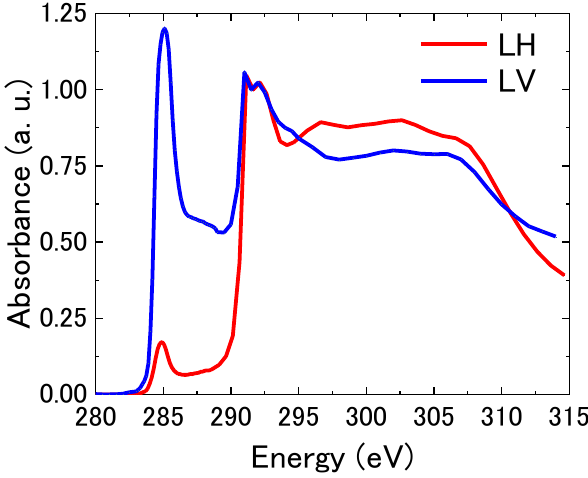
Figure 1. Average C K -edge spectra of the CF areas in Table 3b,c.